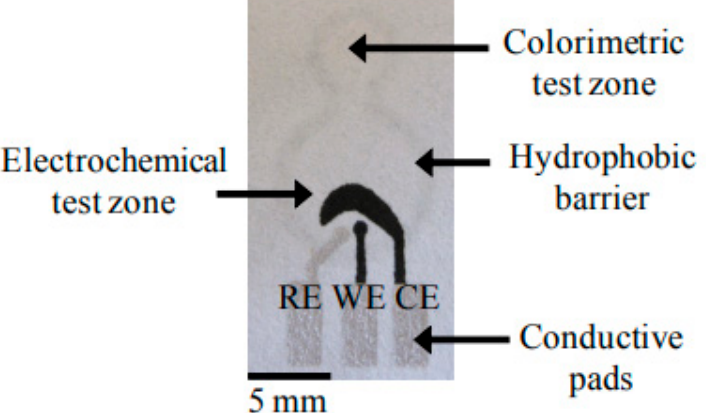
Figure 1. A 2D paper-based microfluidics fabricated using photolithographic method [61]. Total iron was analyzed by colorimetric method involving the formation of red-colored complex between iron(II) and 1,10-phenanthroline as shown in the center of the figure. Abbreviations: RE, reference electrode; WE, working electrode; CE, counter electrode.